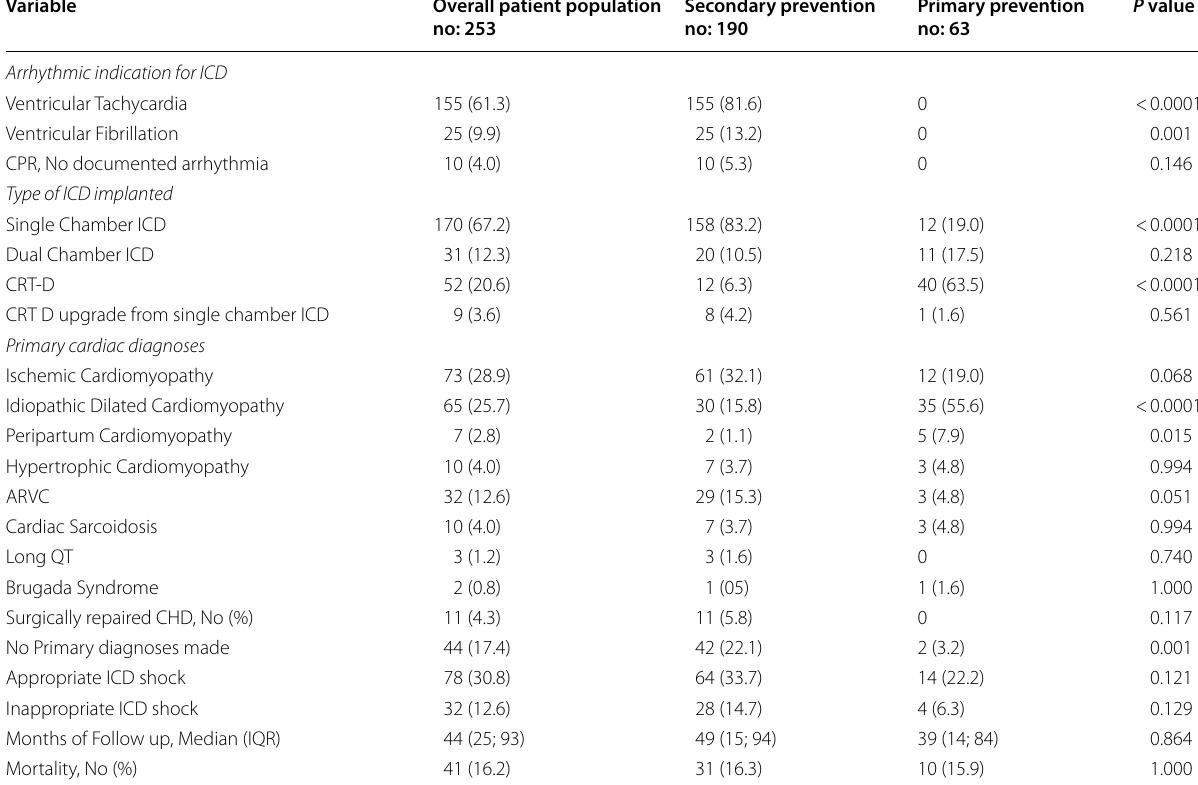
ARVC arrhythmogenic right ventricular cardiomyopathy, ICD implantable cardioverter defibrillator, CRT-D cardiac resynchronization therapy plus a defibrillator, CPR cardiopulmonary resuscitation, CHD congenital heart